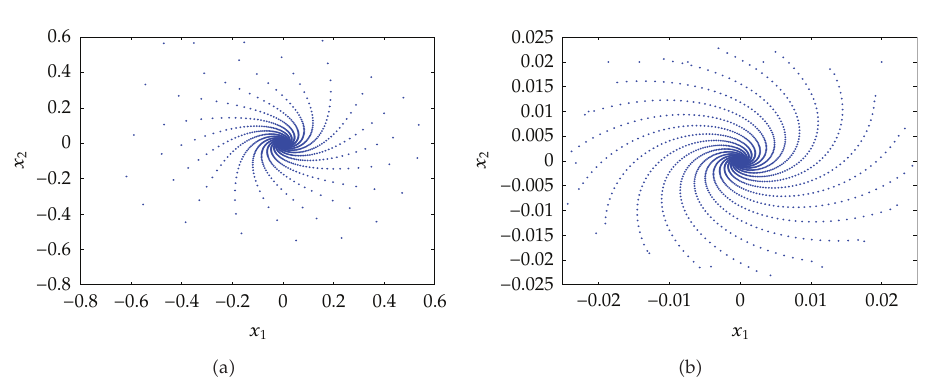
Figure 1: (cid:4) a (cid:6) Phase plot in space (cid:4) x 1 ,x 2 (cid:6) for system (cid:4) 4.1 (cid:6) with initial condition (cid:4) 0.02,0.02 (cid:6) and d 1 (cid:7) 0 . 806. (cid:4) b (cid:6) Phase plot in space (cid:4) x